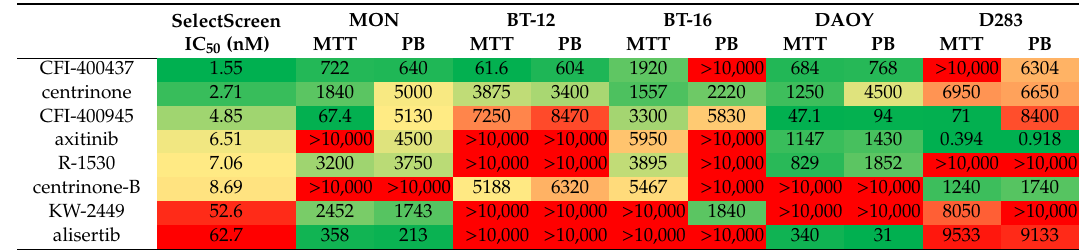
Table 4. Results from cell-based studies. In the first column: Half-maximal inhibitory concentrations (IC 50 ) (SelectScreen, ThermoFisher, USA) from the kinase assay. MTT: IC 50 of the proliferation assay; PB: IC 50 of the PrestoBlue Viability assay (all values in nM) of each cell line (MON, BT-12, BT-16, DAOY, and D283). Green—lowest IC 50 ; Red—highest IC 50